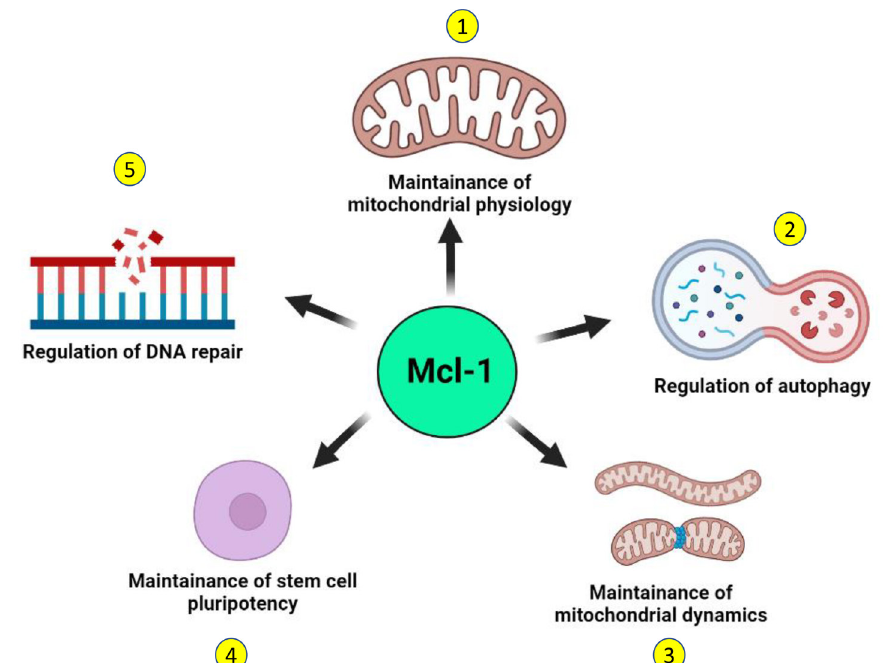
Figure 3. Noncanonical functions of Mcl-1. Independent of its canonical antiapoptotic function, Mcl-1 performs several noncanonical functions in the normal cell that may support the survival of tumor cells. 1. A distinct species of Mcl-1 that localizes to the mitochondrial matrix supports mitochondrial respiration and maintains the organization of the mitochondrial inner